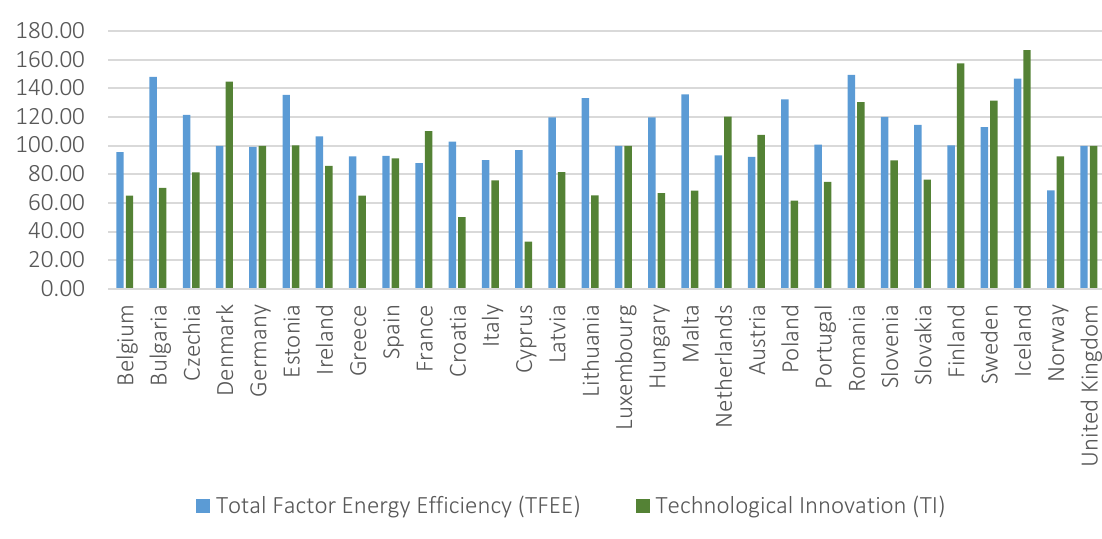
Figure 6. Growth rates of TFEE and TI,